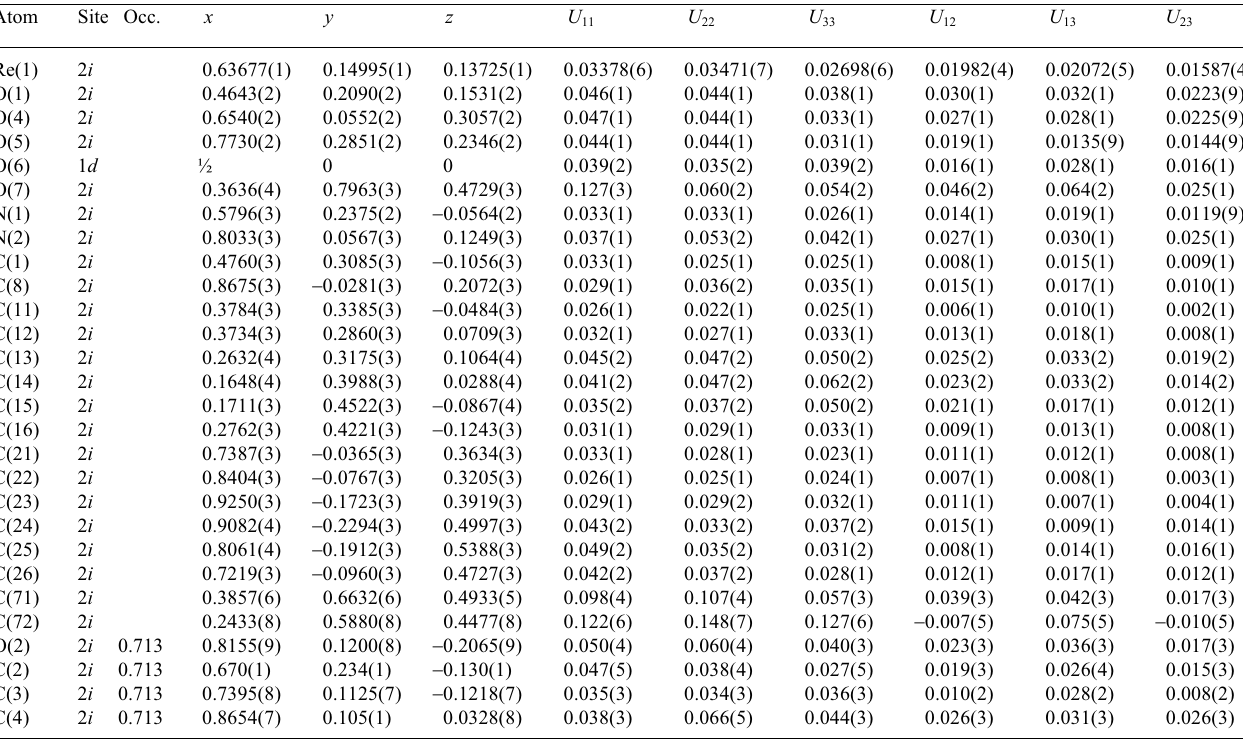
Table 3. Atomic coordinates and displacement parameters (in Å 2 )